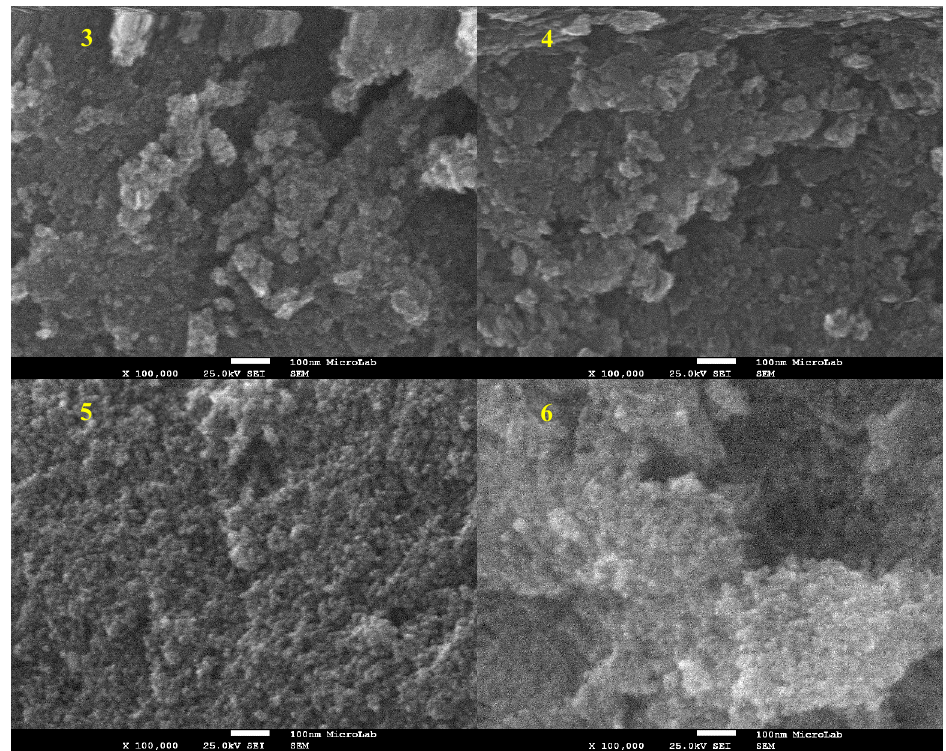
Figure 3. TEM ( top ) and SEM ( bottom ) micrographs of Fe 3 O 4 , Fe 3 O 4 @EDTA ( 0 ) and Fe 3 O 4 @EDTA ‐ M 2+ [M 2+ = Mn 2+ ( 1 ), Fe 2+ ( 2 ), Co 2+ ( 3 ), Ni 2+ ( 4 ), Cu 2+ ( 5 ), Zn 2+ ( 6 )] MNPs.